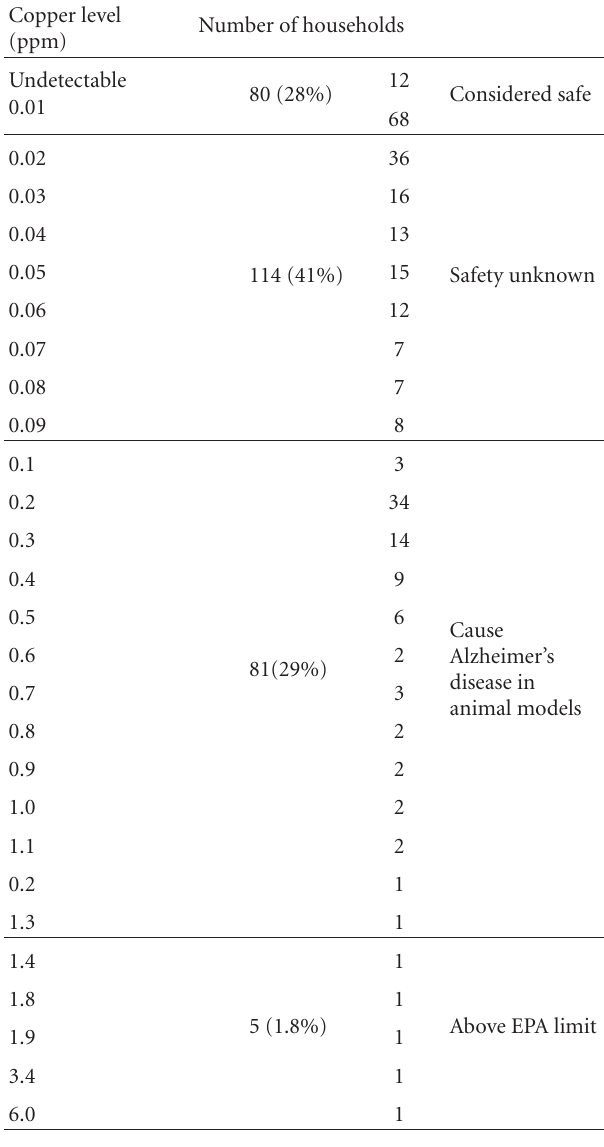
Table 1: Copper levels in Nor American household drinking